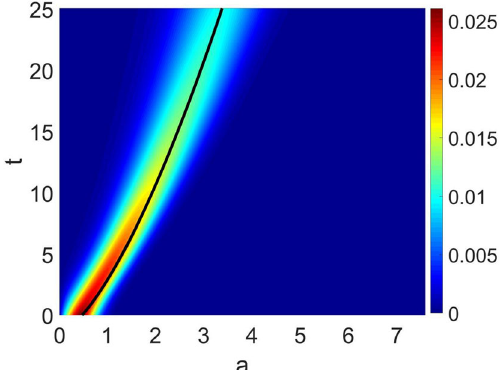
Fig. 9 Evolution of the probability distribution of the scale factor. The horizontal axis represents the scale factor, and the vertical axis repre- sents the time variable. The black curve is the classical trajectory of the universe driven by non-relativistic particles. The parameters are taken as: p a = 5, α = 0 . 5, V 0 = 200, mN m = 3 π p 2 a /( 2 V 2 0